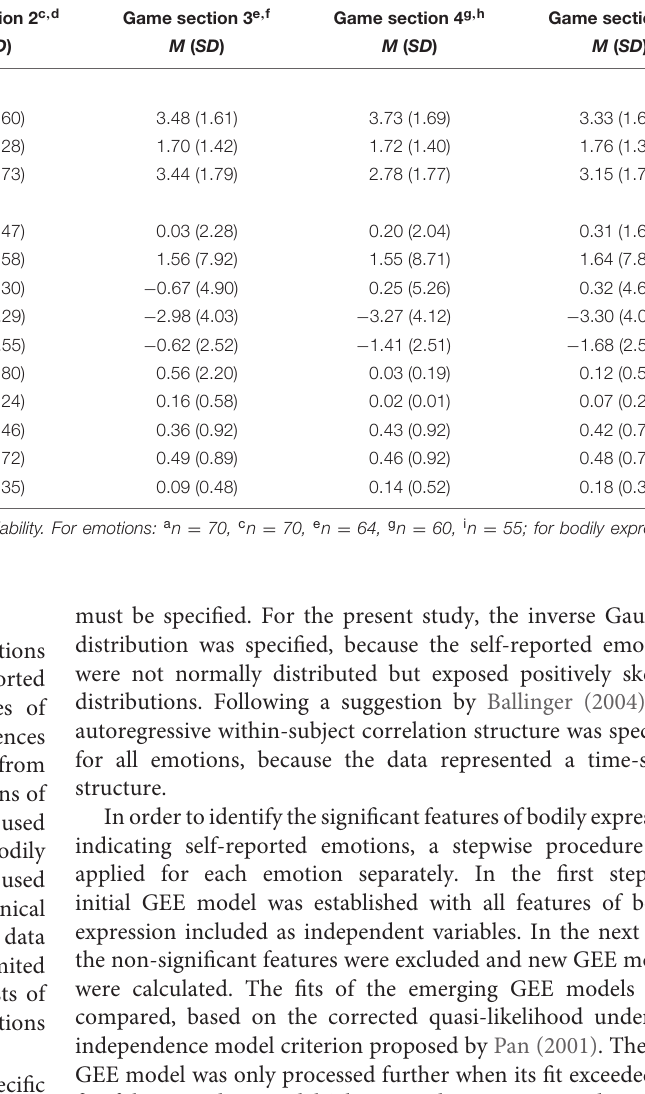
TABLE 2 | Means and standard deviations for self-reported emotional experience and bodily expression over the five game